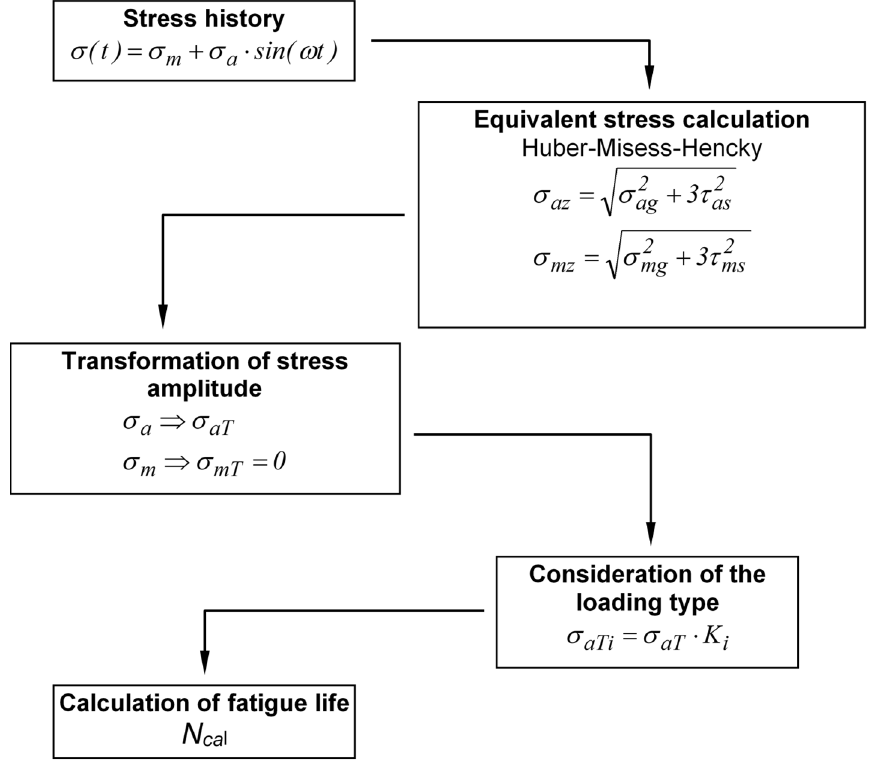
Figure 1. Algorithm for calculating fatigue life.